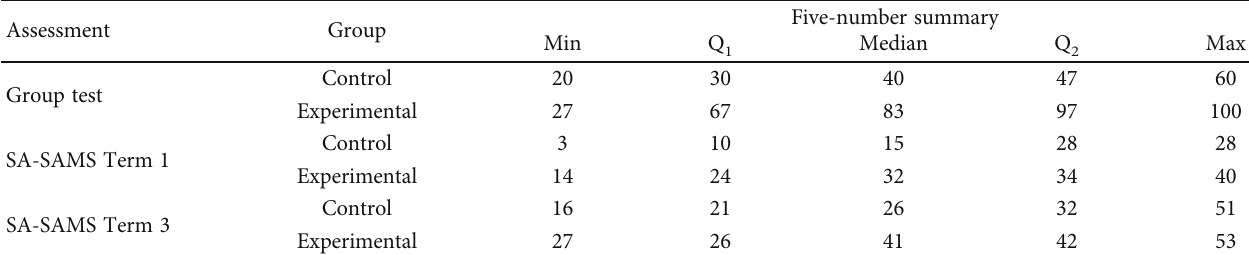
Table 4: Five-number summary of group test and SA-SAMS